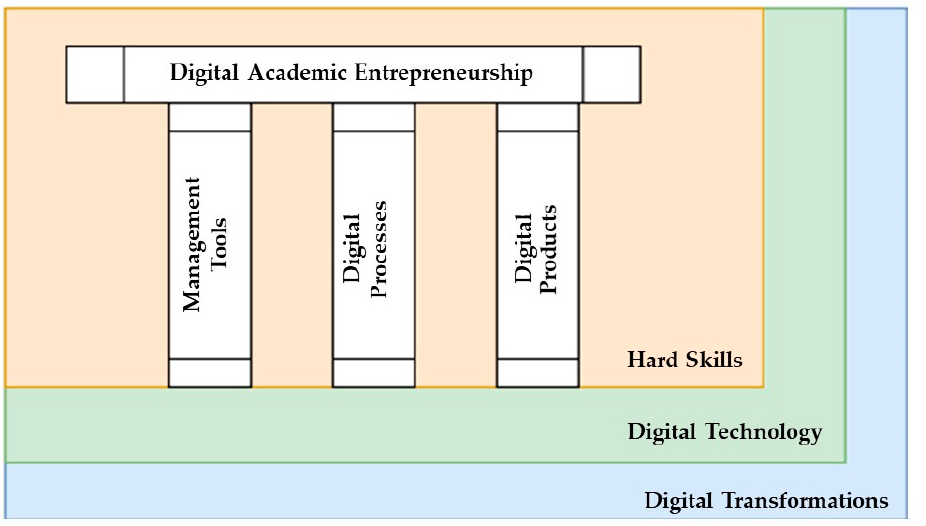
Figure 2. Framework of hard skills for digital academic entrepreneurship. Source: Own elabora- tion.